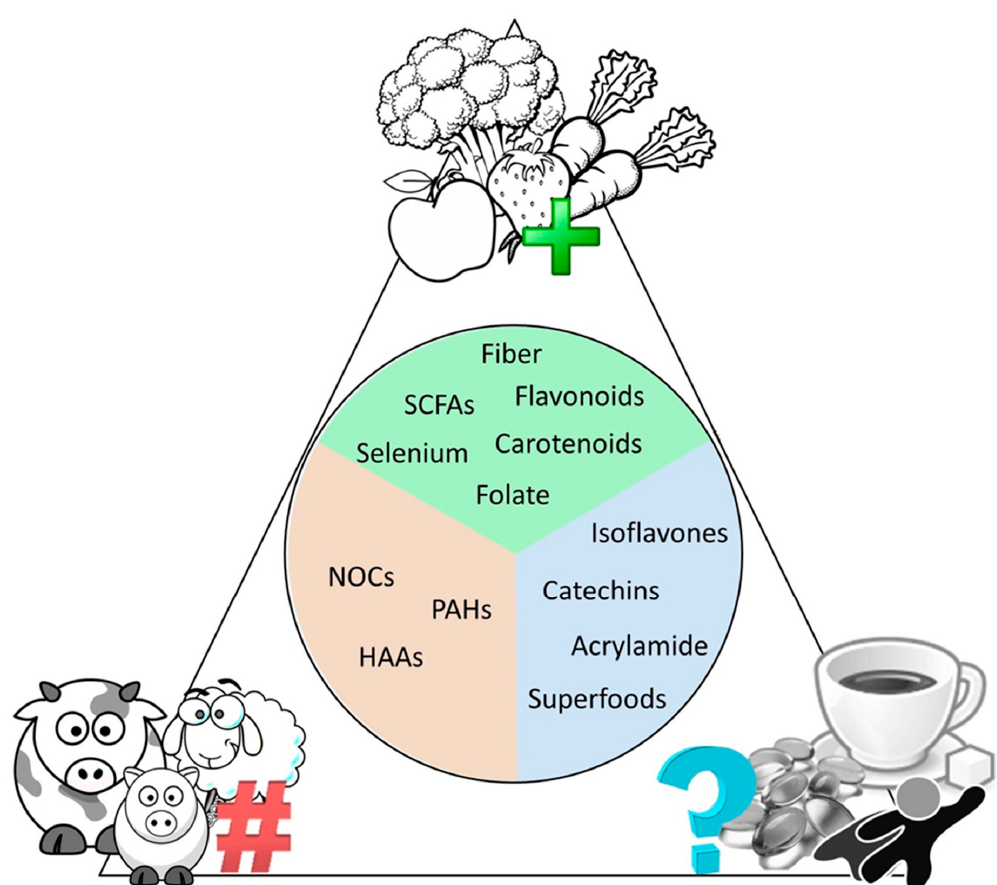
Figure 2. The current consensus on dietary interventions in cancer. What the research studies performed on dietary factors say about their positive, negative, or unknown effects on cancer